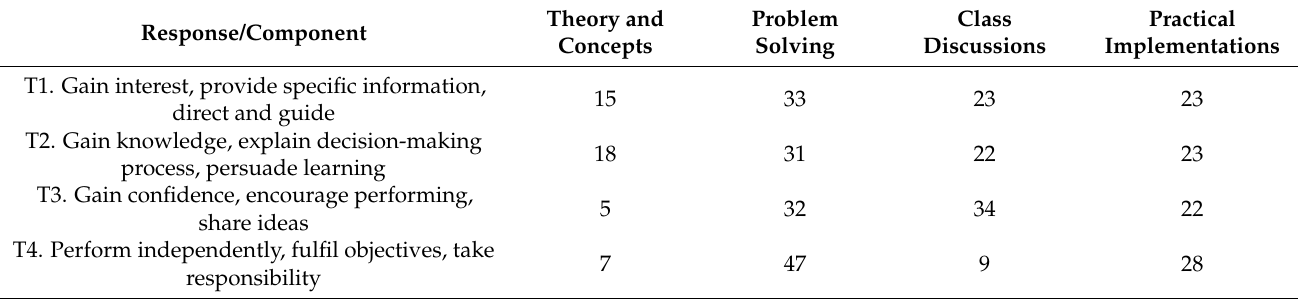
Table 9. Average percentage of responses for the most helpful lecture components (excluding blank, void, and other responses).